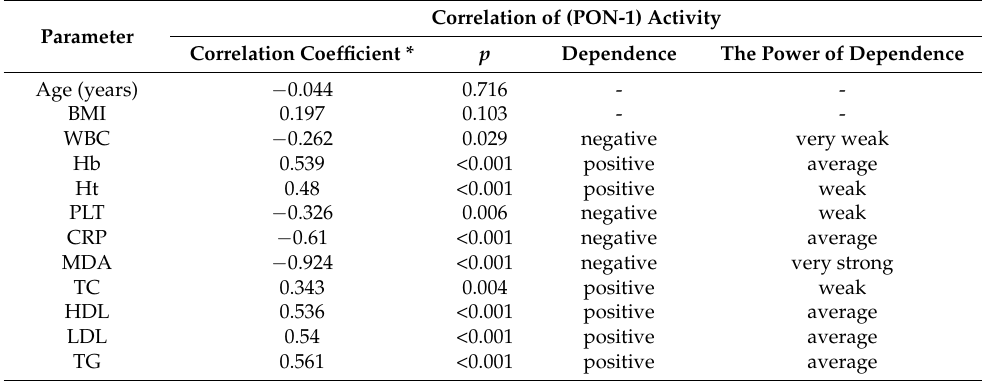
Table 3. Correlation of paraoxonase-1 (PON-1) activity in plasma of patients with CD and constant variables.